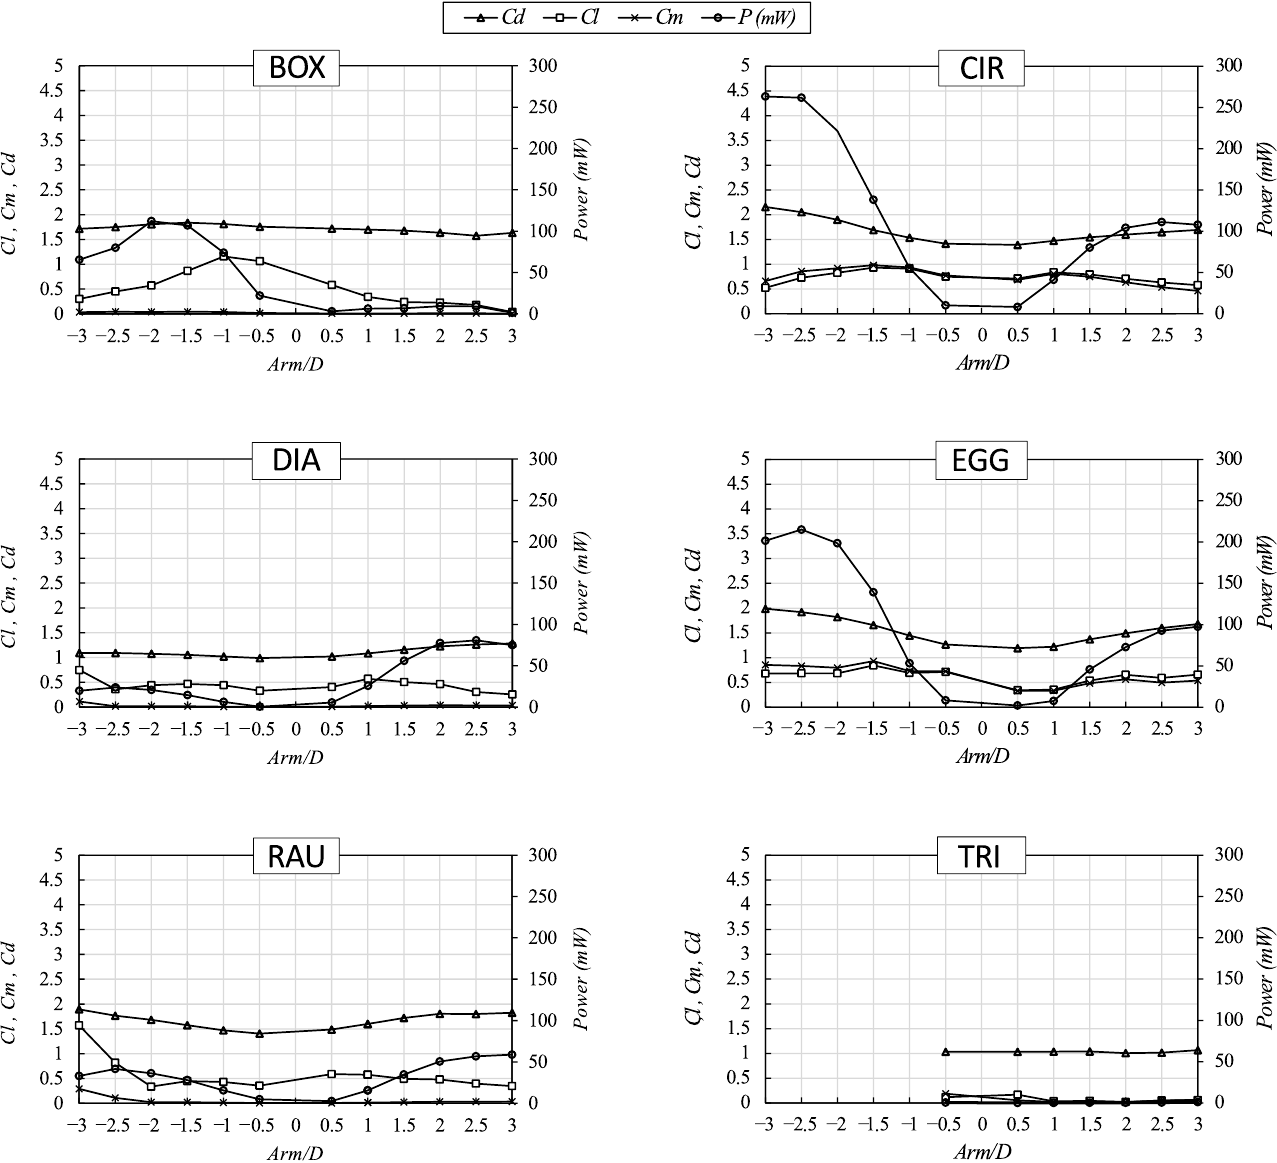
Figure 8. The calculated drag, lift, and moment ratios versus arm ratio for each cross-section. The calculated power is shown on a second